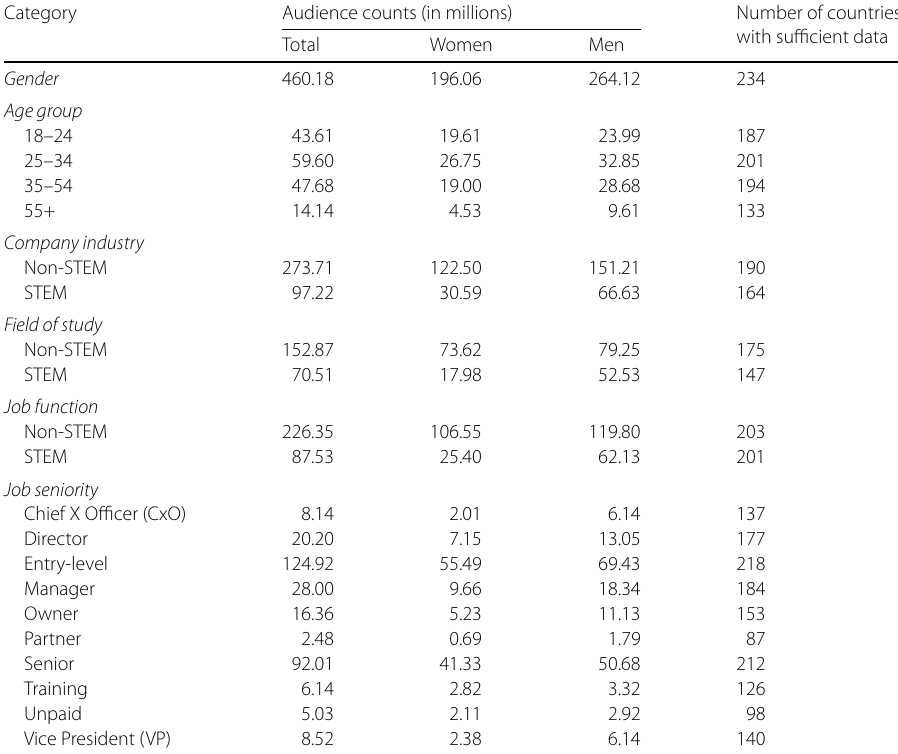
Table 1 Descriptive statistics of LinkedIn data by gender and further disaggregated categories. Note: Number of countries includes those after the application of the observation filter with audience counts of fewer than 1000 removed Category Audience counts (in millions) Number of countries